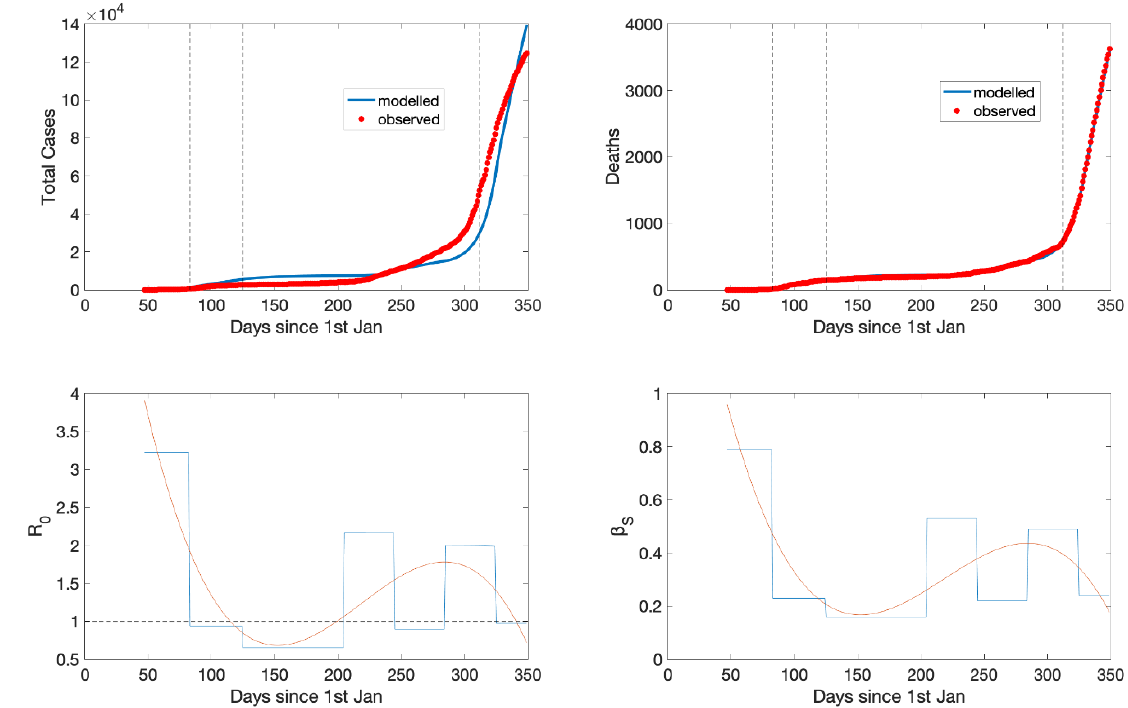
Figure 6. Dynamic evolution of the simulation with optimal transmission rate ( β S ) at each time block. [top row] modelled number of symptomatic infected persons ( I S ) (blue, left panel) and deaths (blue, right panel) together with the observed number of positive cases (red circles) and the observed number of deaths (red circles). [bottom row] Modelled R 0 (blue, left panel) and β S (blue, right panel) together with the polynomial fit (right). See text for explanation.